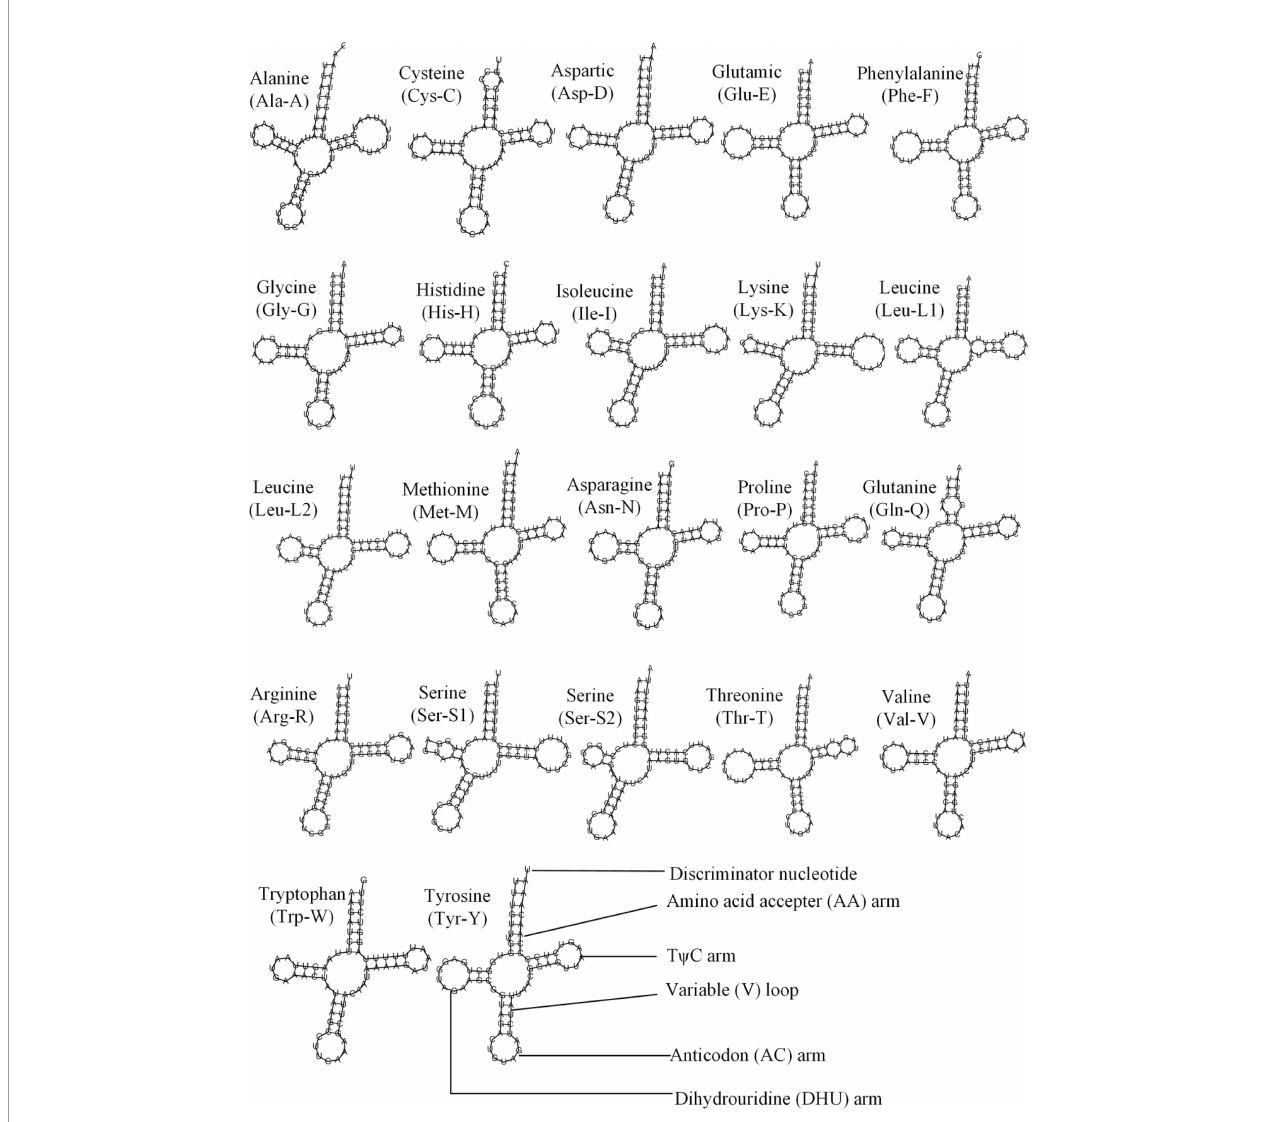
FIGURE 3 | Inferred secondary structures of 22 transfer RNAs (tRNAs) from Lentigo lentiginosus